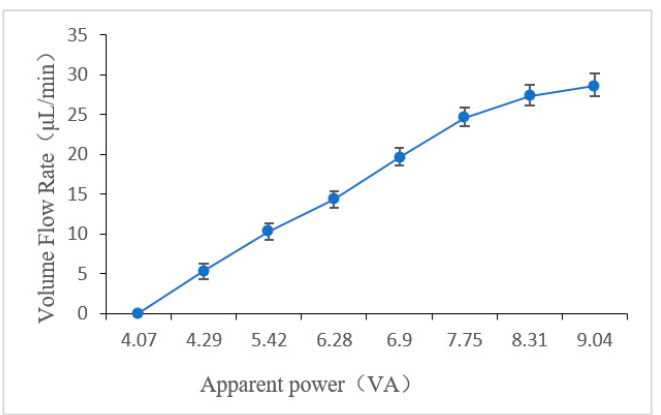
Figure 7. Pumping flow rate VS apparent power.